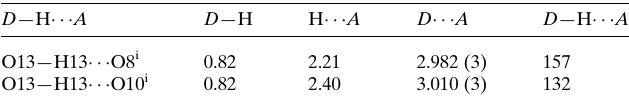
Table 1 Hydrogen-bond geometry (A˚ , (cid:4) ).